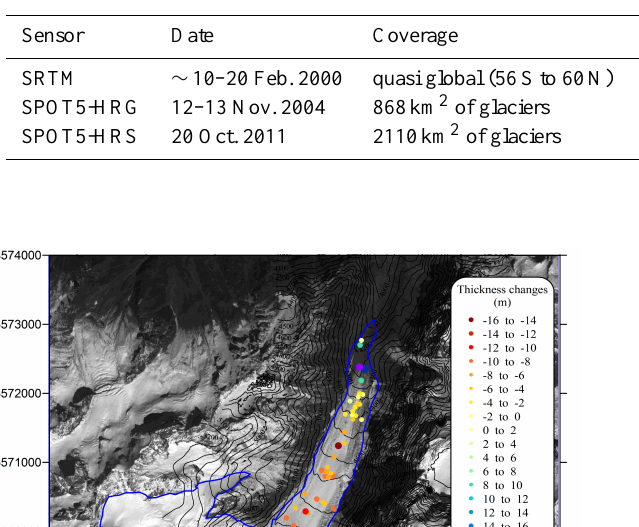
Table 2. Characteristics of the remotely-sensed DEMs used in this study.